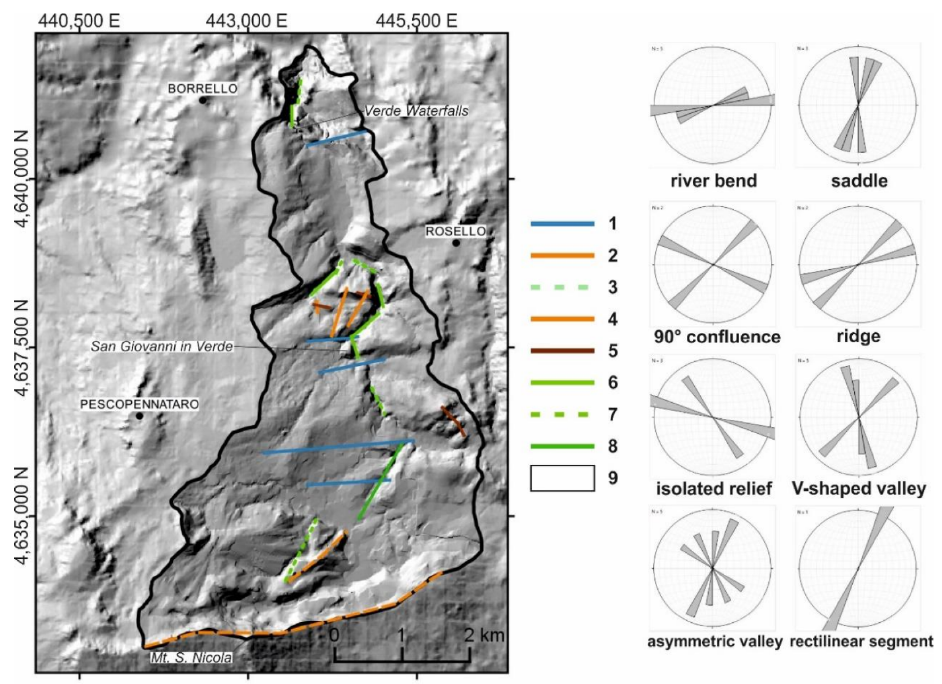
Figure 11. Alignment schema of morphotectonic elements and azimuth distribution of the alignments. Legend: (1) alignment of river bends; (2) alignment of saddles; (3) alignment of 90 ◦ confluence; (4) alignments of ridges; (5) alignment of isolated reliefs; (6) alignment of V-shaped valleys; (7) alignment of asymmetric valleys; (8) alignment of rectilinear fluvial segment; (9) watershed boundary.